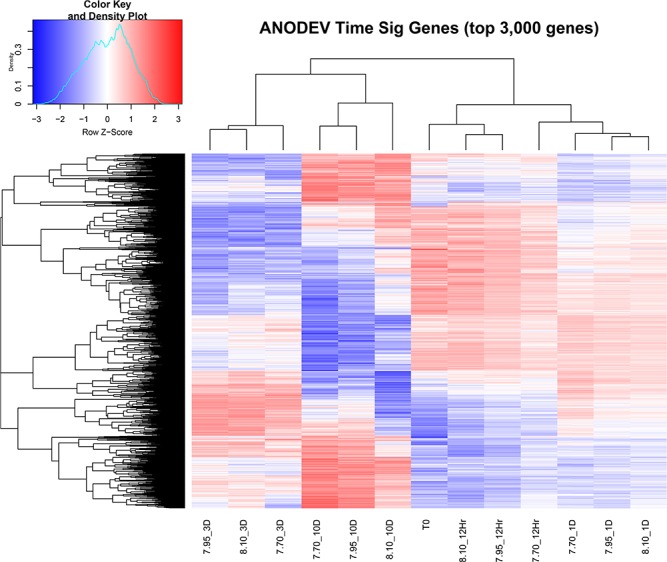
Heatmap of the top 3000 differentially expressed genes changing over time for experiment E. Sampling labeling provides treatment pH followed by sampling day, notice clustering of samples is by day first and then by treatment.